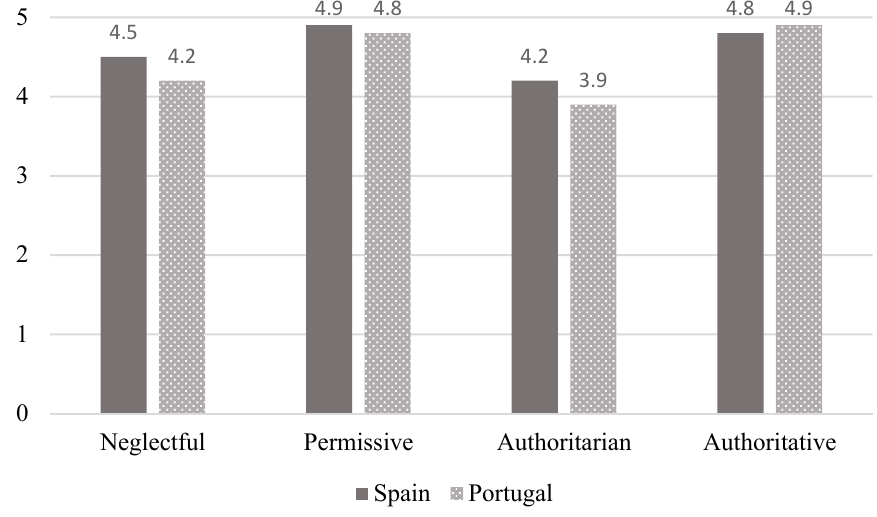
Figure 3. Di ff erences in wellbeing according to parenting styles in Spain and Figure 3. Differences in wellbeing according to parenting styles in Spain and Portugal.